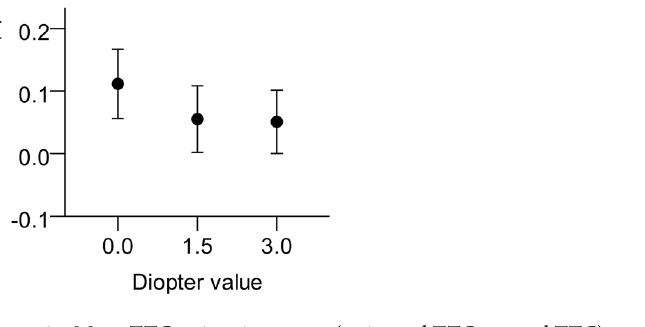
Figure 2. Mean TTC estimation errors (estimated TTC—actual TTC) as a function of diopter value. Error bars represent ± 1 standard error of the mean across participants.